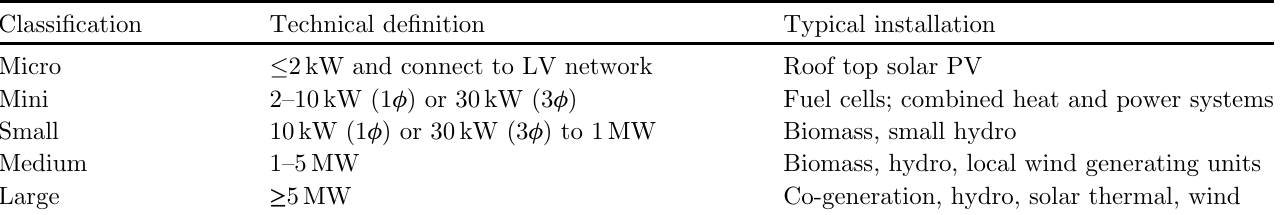
Table 1. Classi fi cation of DG units in the National Electricity Market of Australia. (Adapted from the Australian Energy Market Operator